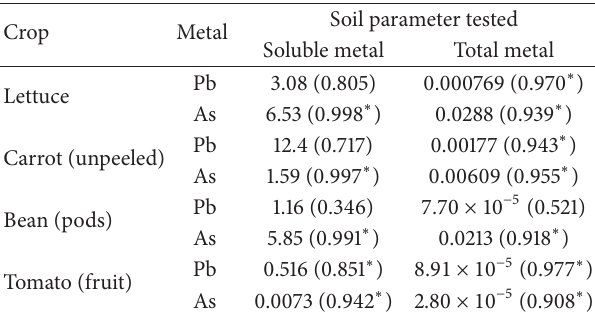
Table 2: Linear regression slopes and 𝑟 -values (in parentheses) for correlations between vegetable Pb and As concentrations (mgkg − 1 ) and soil soluble (mgL − 1 ) and total Pb and As (mgkg − 1 ). 𝑟 -values denoted with asterisks are significant at the 5% level.